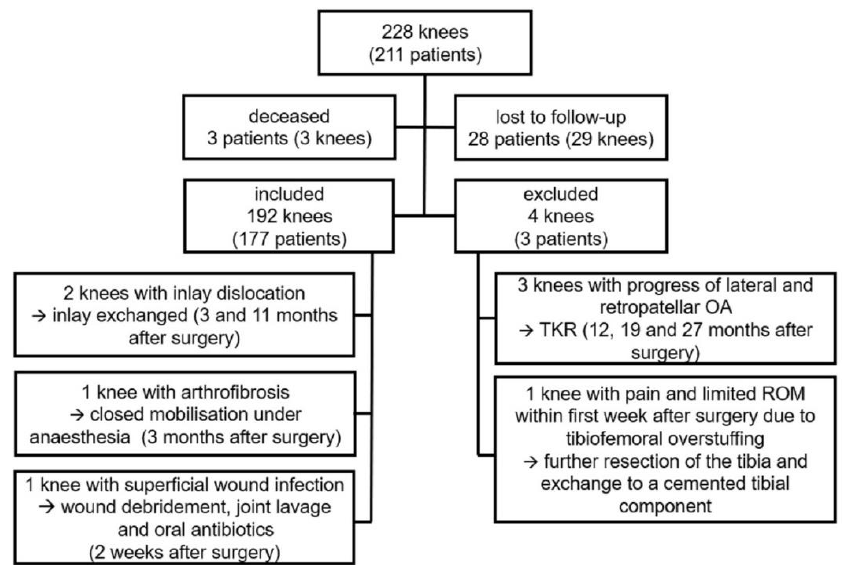
Figure 3. Overview of patient